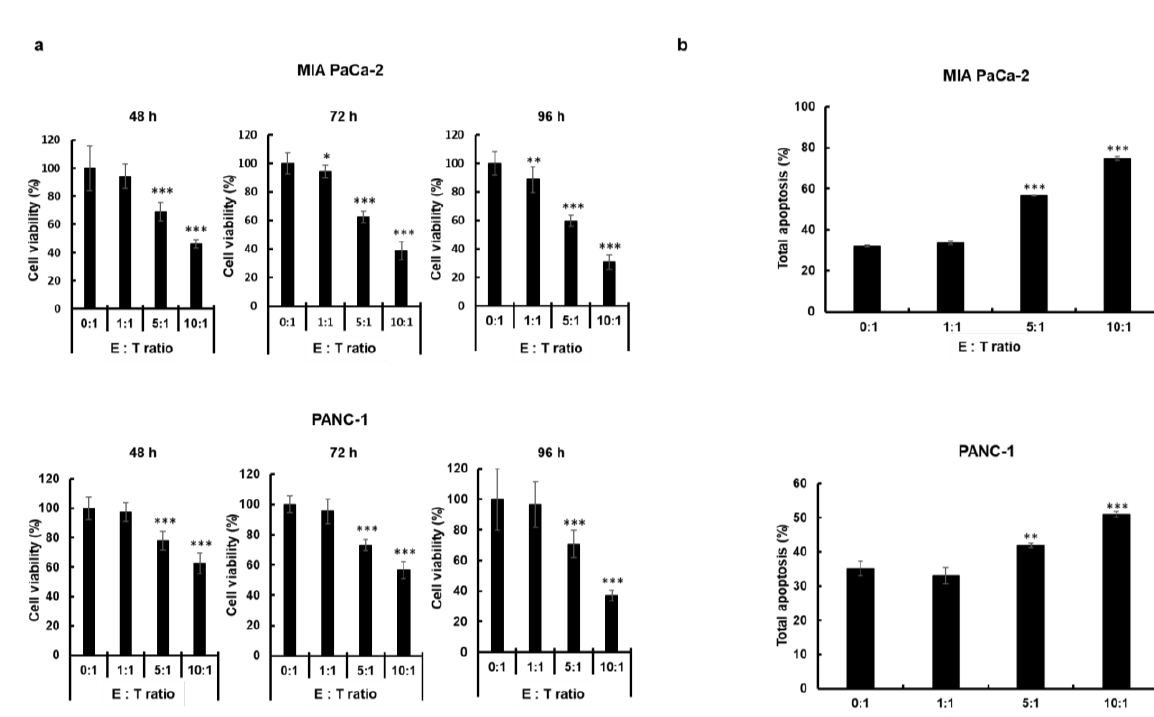
Figure 5. Pancreatic cancer cell killing e ff ect of the natural killer (NK) cells via induction of apoptosis. ( a ) Human pancreatic cancer cells (MIA PaCa-2 and PANC-1) were incubated with NK cells at various e ff ector-to-target (E:T) ratios. At 48, 72, and 96 h after treatment, cell viability was measured by 3-(4,5-dimethylthiazol-2-yl)-2,5-diphenyltetrazolium bromide (MTT) assay. Each cell line was tested at least three times, and data are shown as mean ± standard deviation (SD) of triplicate experiments; * p < 0.05, ** p < 0.01, *** p < 0.001. ( b ) Human pancreatic cancer cells (MIA